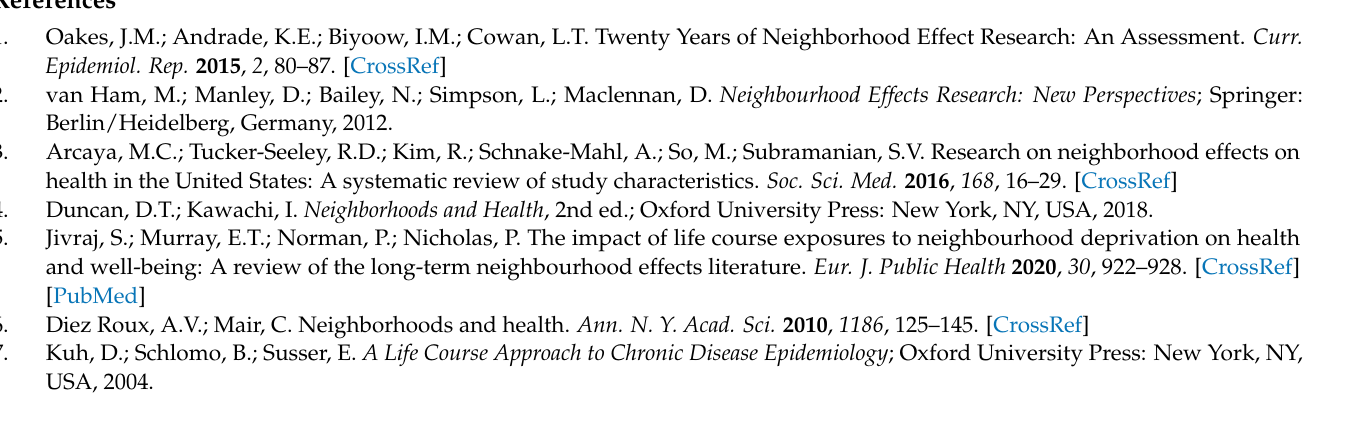
Table S2: Direct effects modelled using structural equation modelling and multiple imputation (1970 cohort, n = 18,639), Bonferroni corrections applied; Supplementary Table S3: Direct effects modelled using structural equation modelling and multiple imputation (1958 cohort, n = 18,555), Bonferroni corrections applied; Supplementary Table S4: p -values for interaction tests of moving between intervals on area deprivation and health selection